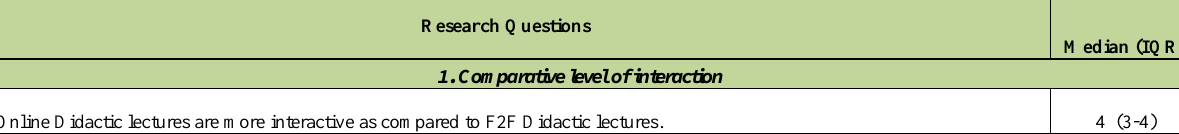
Table 1. Item wise average score for student’s Perception towards online academic activity vs. F2F academic